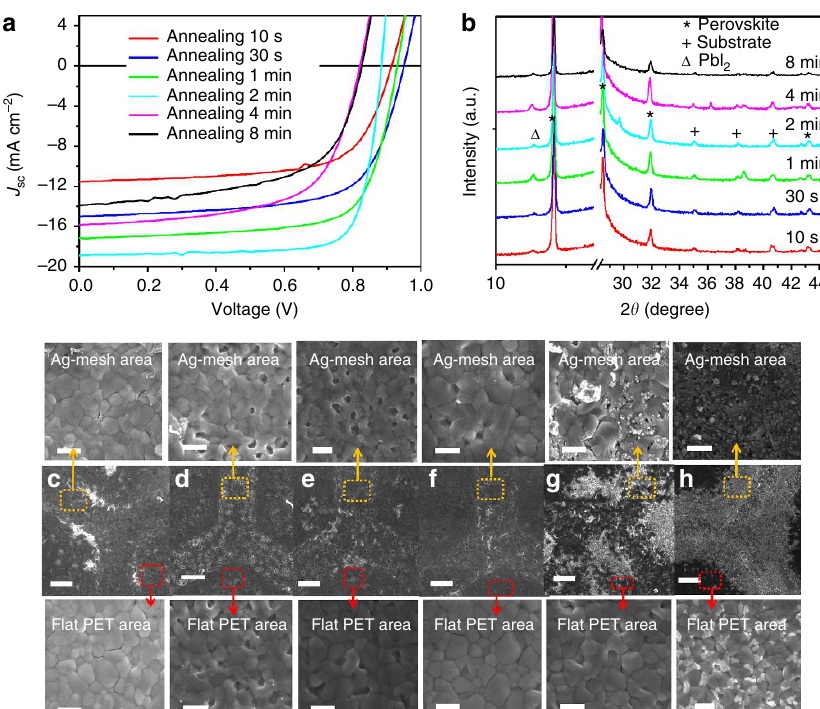
Figure 5 | Annealing-time evolution of the perovskite films. Annealing MAPbI 3 grown on PET/Ag-mesh/PH1000/PEDOT:PSS substrate at 130 (cid:2) C for 10s, 30s, 1min, 2min, 4min and 8min, respectively: ( a ) J – V curves of the corresponding solar cells. ( b ) X-ray diffraction patterns of the perovskite films. ( c – h ) Top-view SEM images of the perovskite films coated on both flat PET and Ag-mesh area (scale bar, 2 m m): ( c ) 10s; ( d ) 30s; ( e ) 1min; ( f ) 2min; ( g ) 4min; ( h ) 8min. Ag-mesh area row: the SEM images of corresponding perovskite films coated on Ag-mesh (scale bar, 500nm); Flat PETarea row: SEM images of corresponding perovskite films coated on flat PET (scale bar,